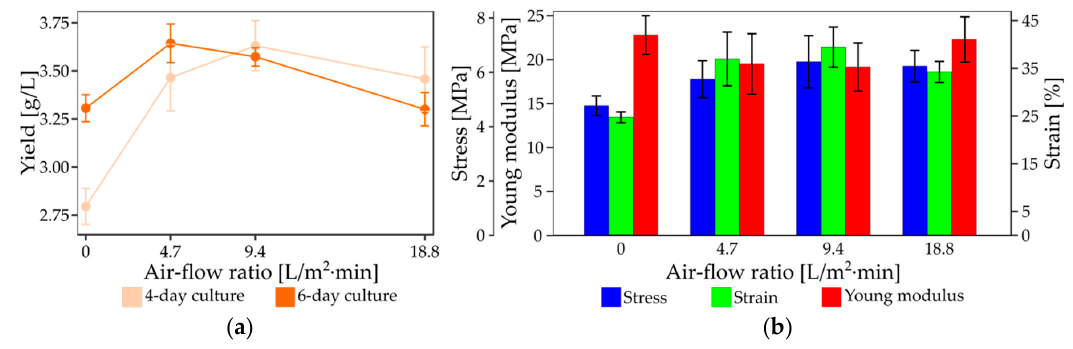
Figure 4. Impact of air-flow ratio on ( a ) biosynthesis yield and ( b ) tensile parameters of bacterial nanocellulose after 6-day